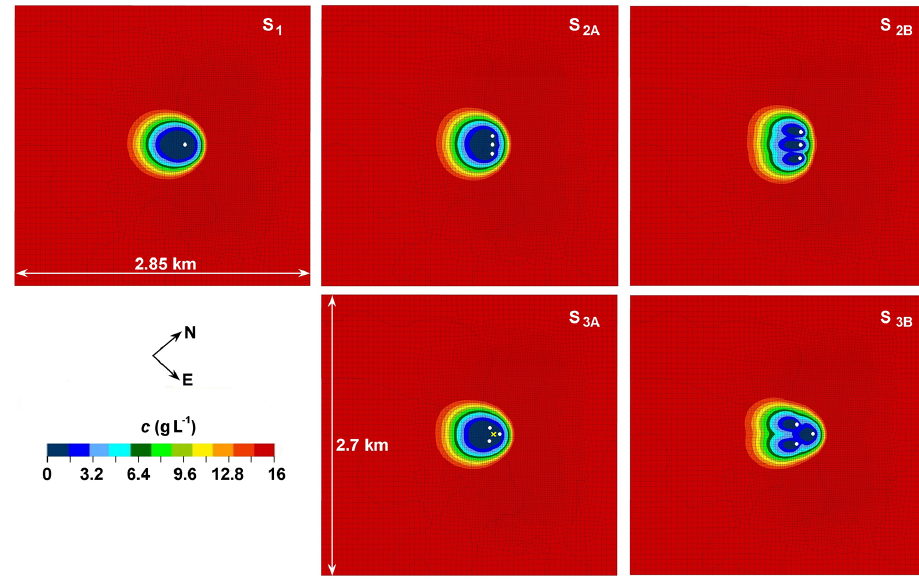
Figure 13. The salt concentration (gL − 1 ) on a horizontal plane at − 30ma.m.s.l. (i.e., at the top of the injected aquifer) after 2 years of aquifer recharge for the various scenarios addressed by the study. The location of the injection wells are shown by the white dots. The production well in scenario S 3A is marked by a yellow